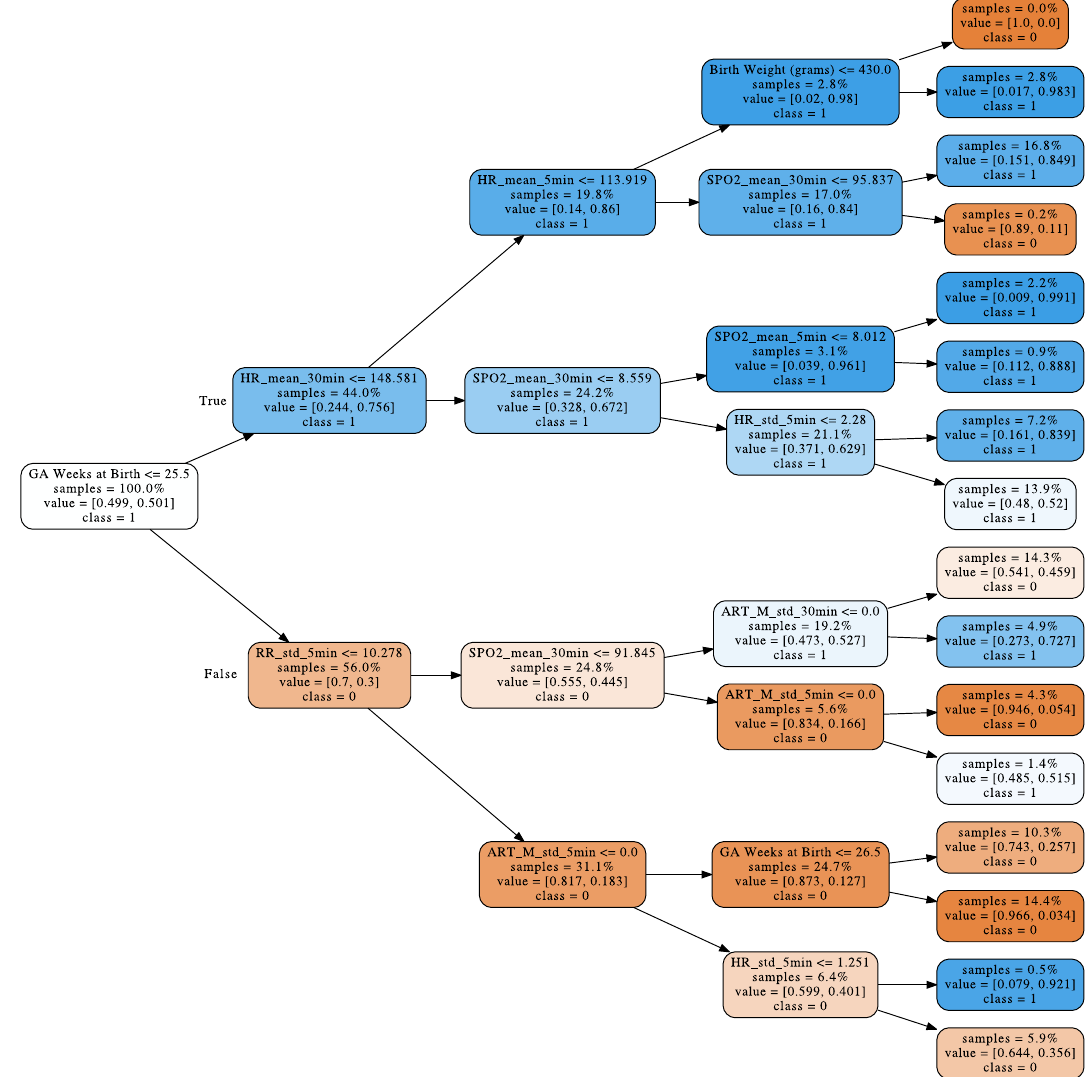
indicates a majority prediction of “worry.” A more intense coloring designates a lower Gini impurity, which in turn indicates a lower likelihood of